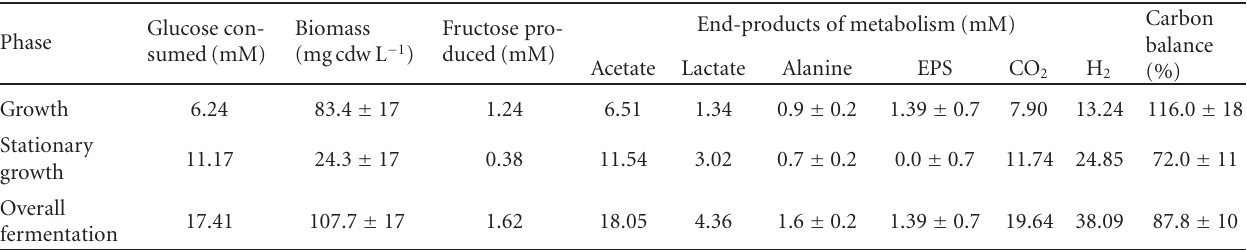
Table 1: Batch balance for Thermotoga maritima grown on BM under anoxic conditions.